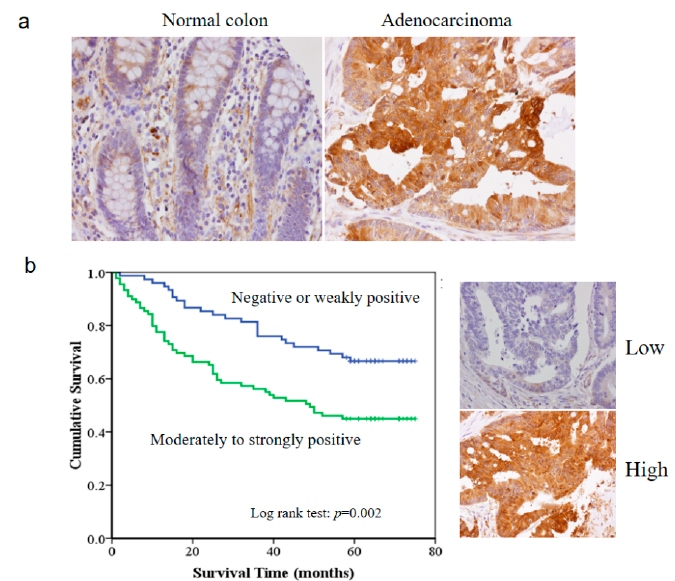
Figure 1. The HSP27 expression level correlates with clinicopathologic characters in colon adenocarcinoma. ( a ) HSP27 expression was higher in colon adenocarcinoma tissue than non- neoplastic colon tissue ( p = 0.001). ( b ) Moderate/strong HSP27 expression was linked with poorer prognosis than weak HSP 27 expression ( p = 0.002).